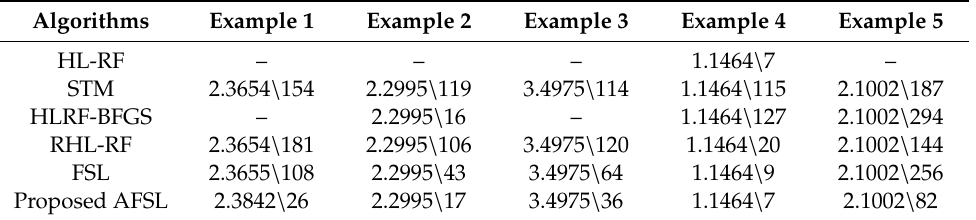
Table 8. Convergent results (i.e., reliability index \ iterations) for Examples 1–5.